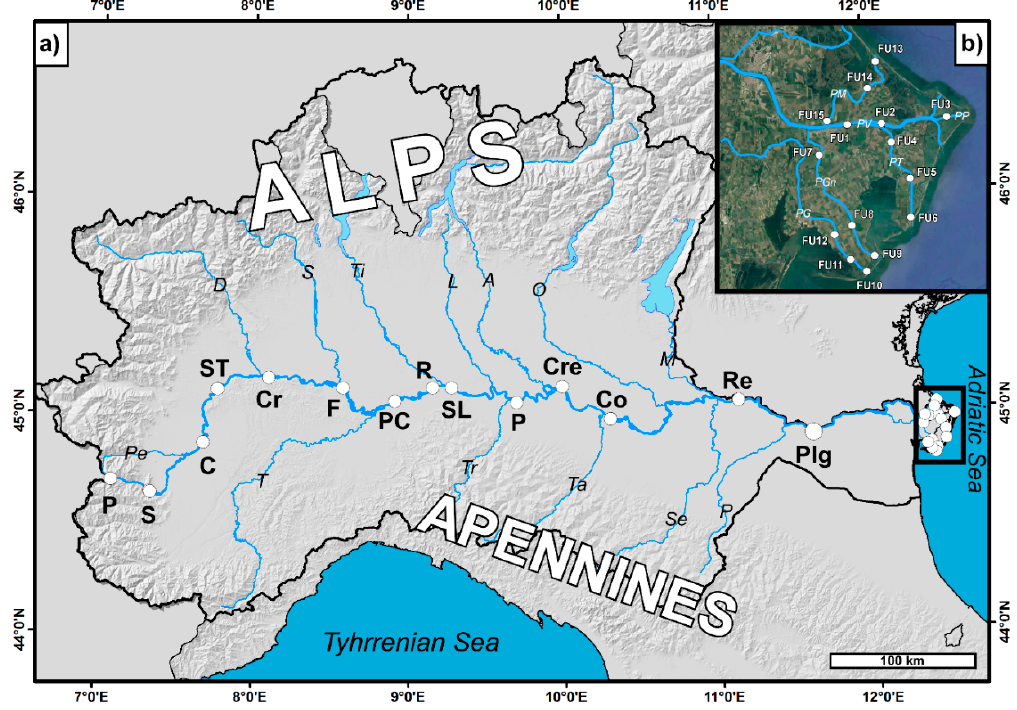
Figure 1. ( a ) Map of the Po river catchment reporting the sampling sites along the Po plain and ( b ) its delta. Circles and abbreviated labels represent the sampling sites along the Po river. The abbreviation of the sampling sites is explained in Tables 1–3 that also includes geographic coordinates. Note that the sampling site of Pontelagoscuro (Plg) is marked by a larger circle to highlight that in this specific site, water sampling and analysis has been repeated several times. The abbreviations of the tributaries are: Pe (Pellice), D (Dora Baltea), S (Sesia), Ti (Ticino), L (Lambro), A (Adda), O (Oglio), M (Mincio), T (Tanaro), Tr (Trebbia), Ta (Taro), Se (secchia), P